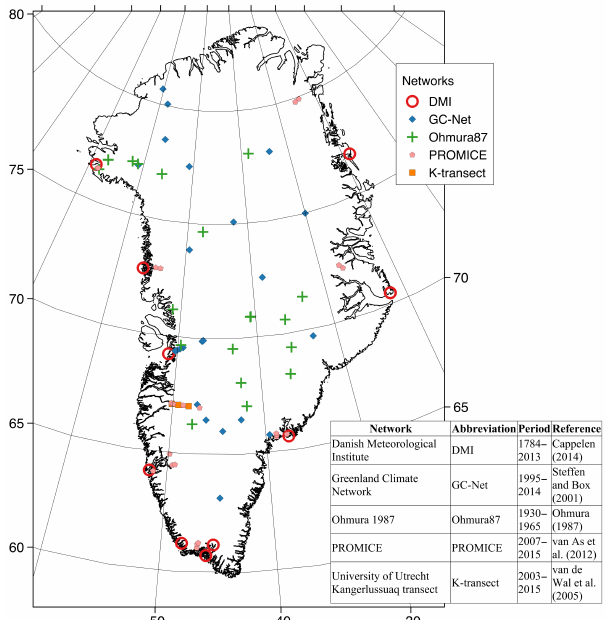
Figure 1. Map of study area and weather stations used in this work. Symbol types represent the different monitoring networks summa- rized in the inserted